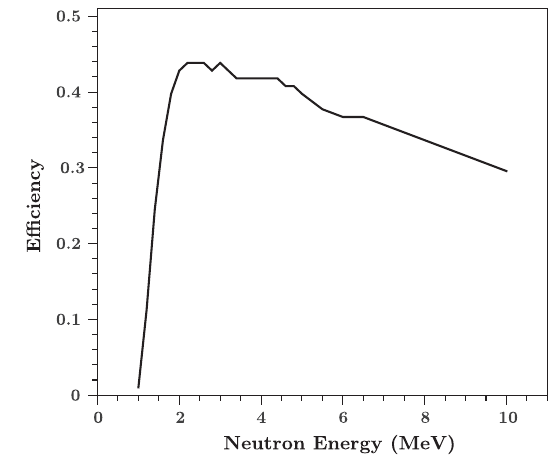
FIG. 17. Absolute neutron detection efficiency calculated for one RIPEN detector.